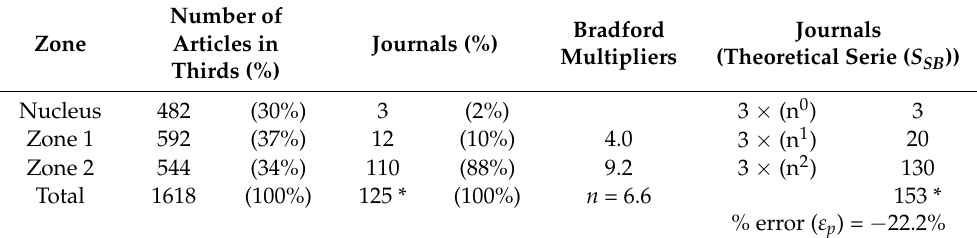
Table 1. Publications on coffee agronomy by Bradford’s zones between 1963 and 2020.